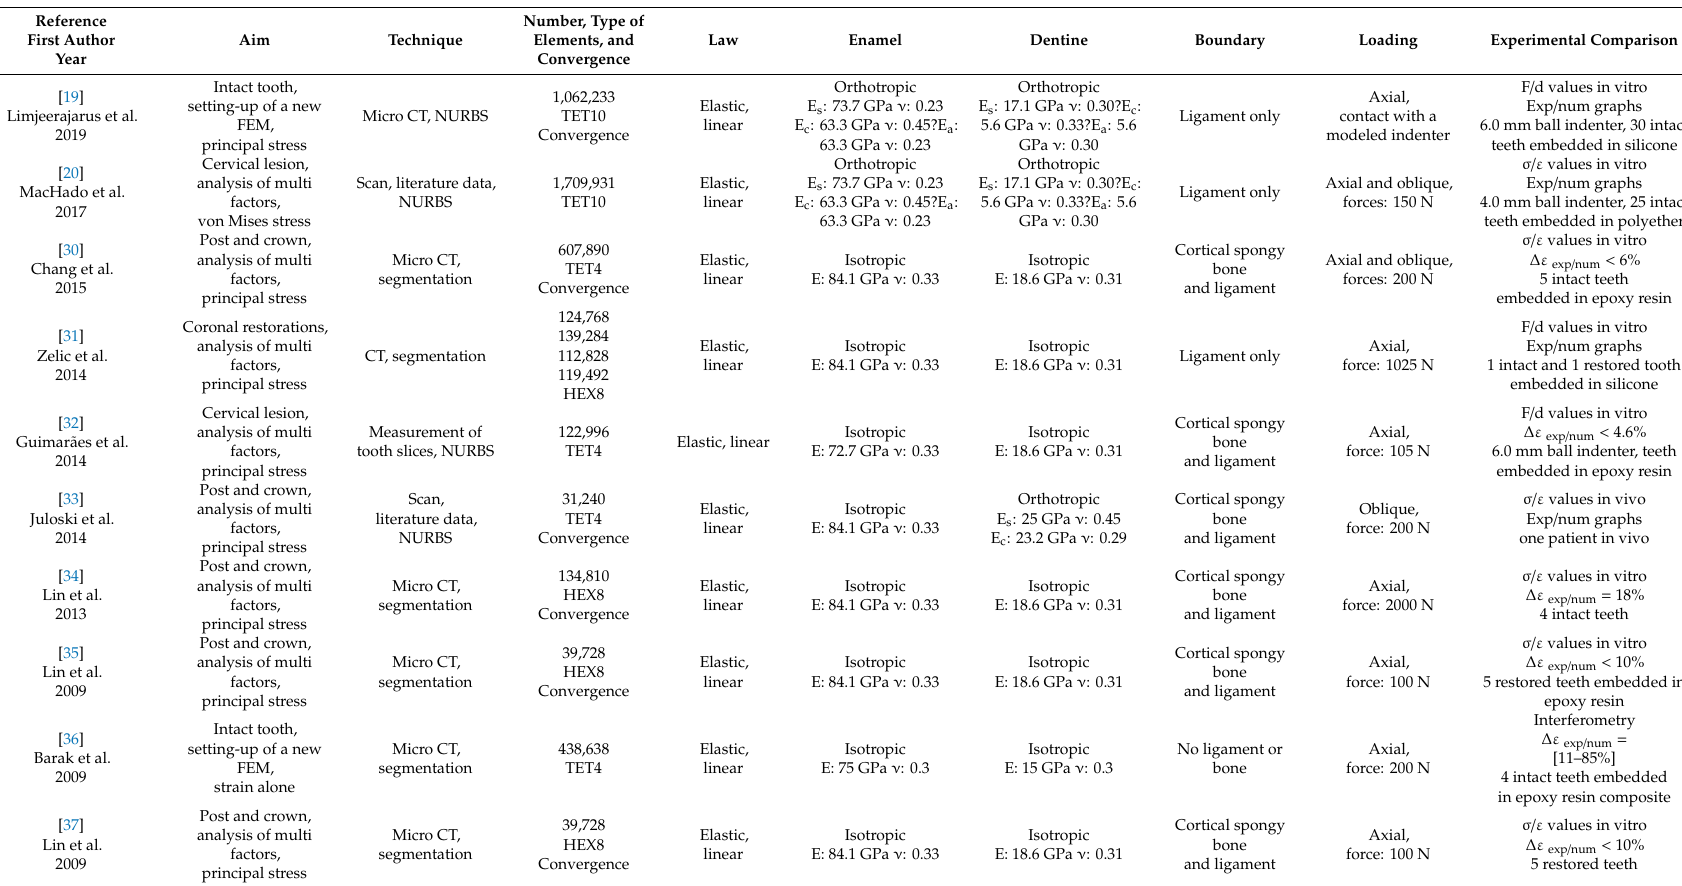
Table 2. Main characteristics and parameters of the included studies. CT refers to computed tomography, NURBS refers to Non-Uniform Rational Basis Splines, TET4 refers to a four-node tetrahedral element, TET10 refers to a ten-node tetrahedral element, HEX8 refers to an eight-node hexahedral element, GPa refers to gigapascal, mm refers to millimeter, N refers to newton, F / d refers to a measurement of force using a force sensor and displacement of the universal testing device, Exp / num refers to a quantified evaluation between experimental and numerical data, and σ / ε refers to stress / strain